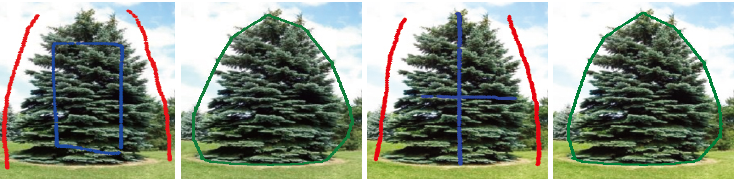
Figure 7. The robustness tests of different initial contours on our image segmentation methods with some original images shown in Figure 3. In each row of the figure, the first two columns and the last two columns show the original images with given initial contours and our corresponding image segmentation results, respectively.